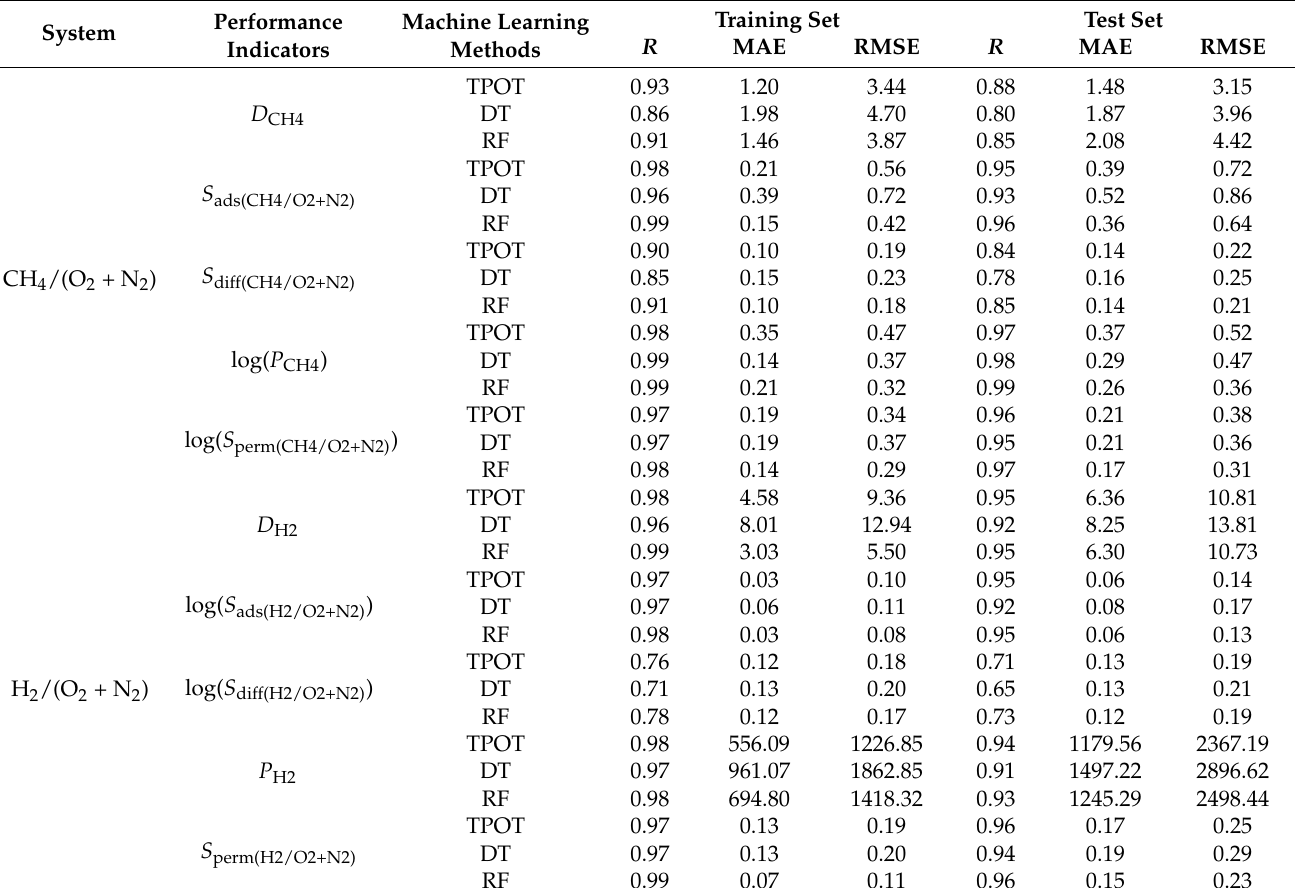
Table 1. Evaluation of three ML algorithms for the systems of CH 4 /(O 2 + N 2 ) and H 2 /(O 2 + N 2 ). System